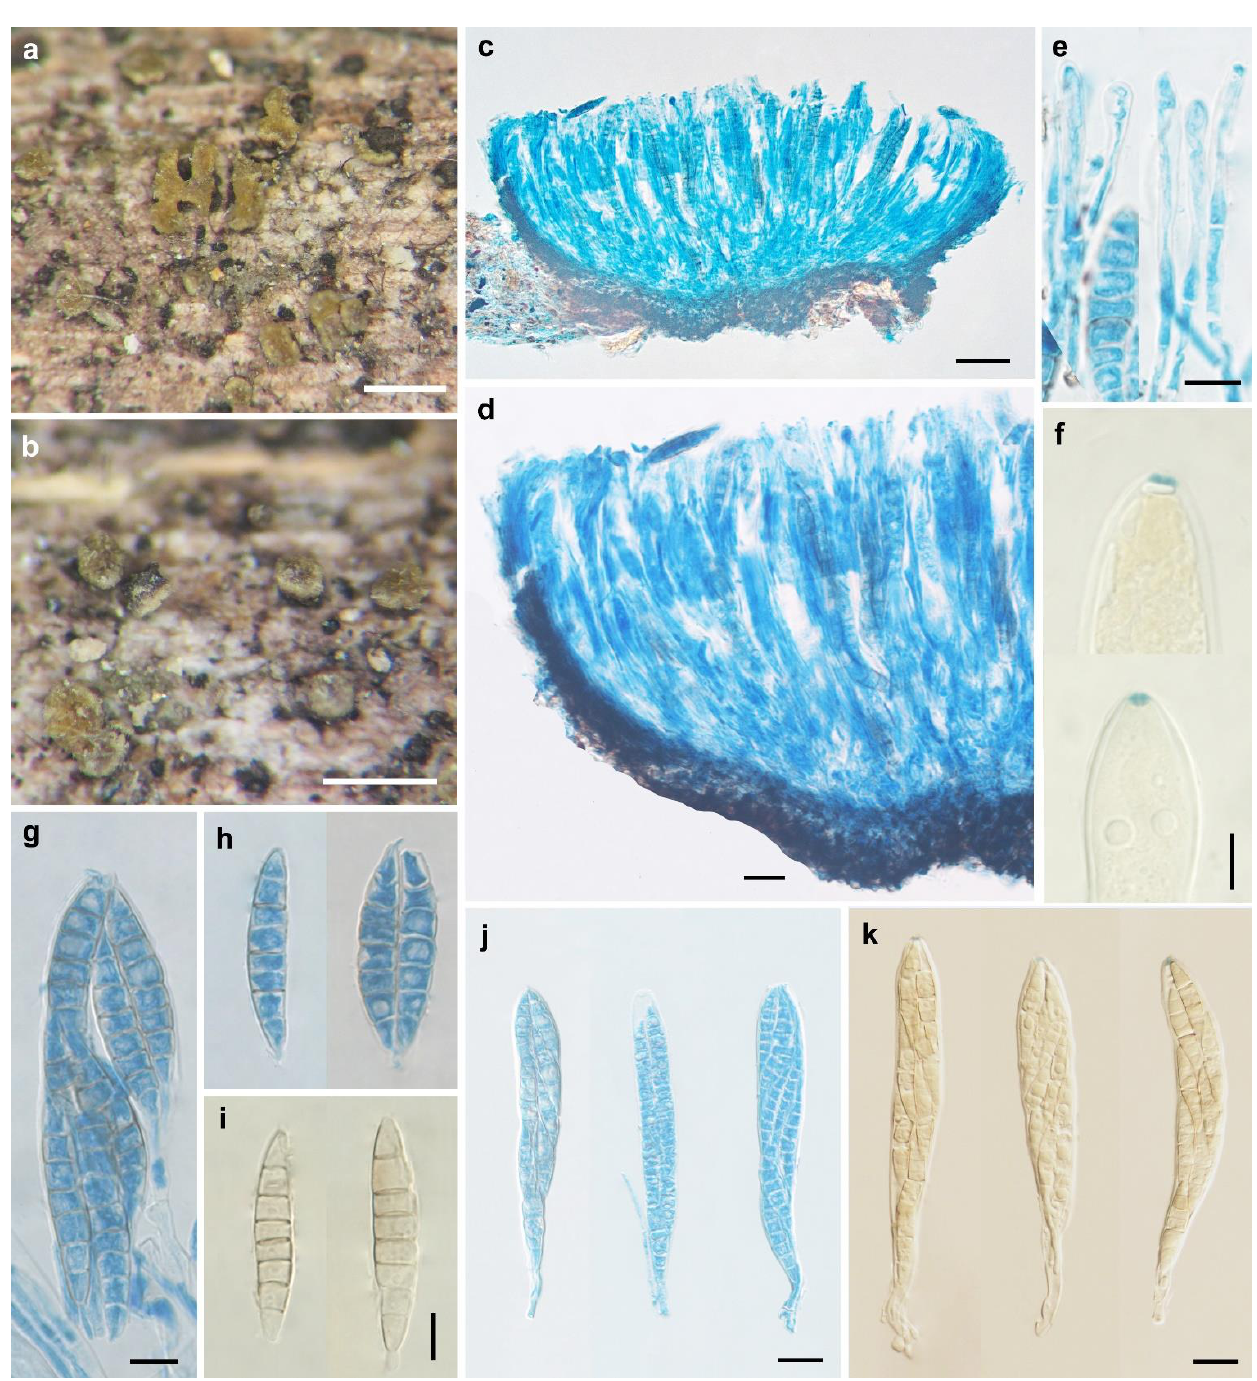
Figure 3. Pezicula fusispora W.Y. Zhuang & H.D. Zheng (HMAS 290892, holotype). ( a , b ) Dry apothecia on natural substrate; ( c ) longitudinal section of apothecium; ( d ) longitudinal section of apothecium (partial) showing excipular and hymenium structure; ( e ) paraphyses; ( f ) IKI reaction of ascus apical ring without KOH pretreatment; ( g – i ) ascospores; ( j , k ) asci. Scale bars: ( a , b ) = 0.5 mm; ( c ) = 50 μm; ( d , j , k ) = 20 μm; ( e – i ) = 10 μm. Mounting media: ( c – e , g , h , j ) lactophenol cotton blue; ( f , i , k ) Lugol’s solution.